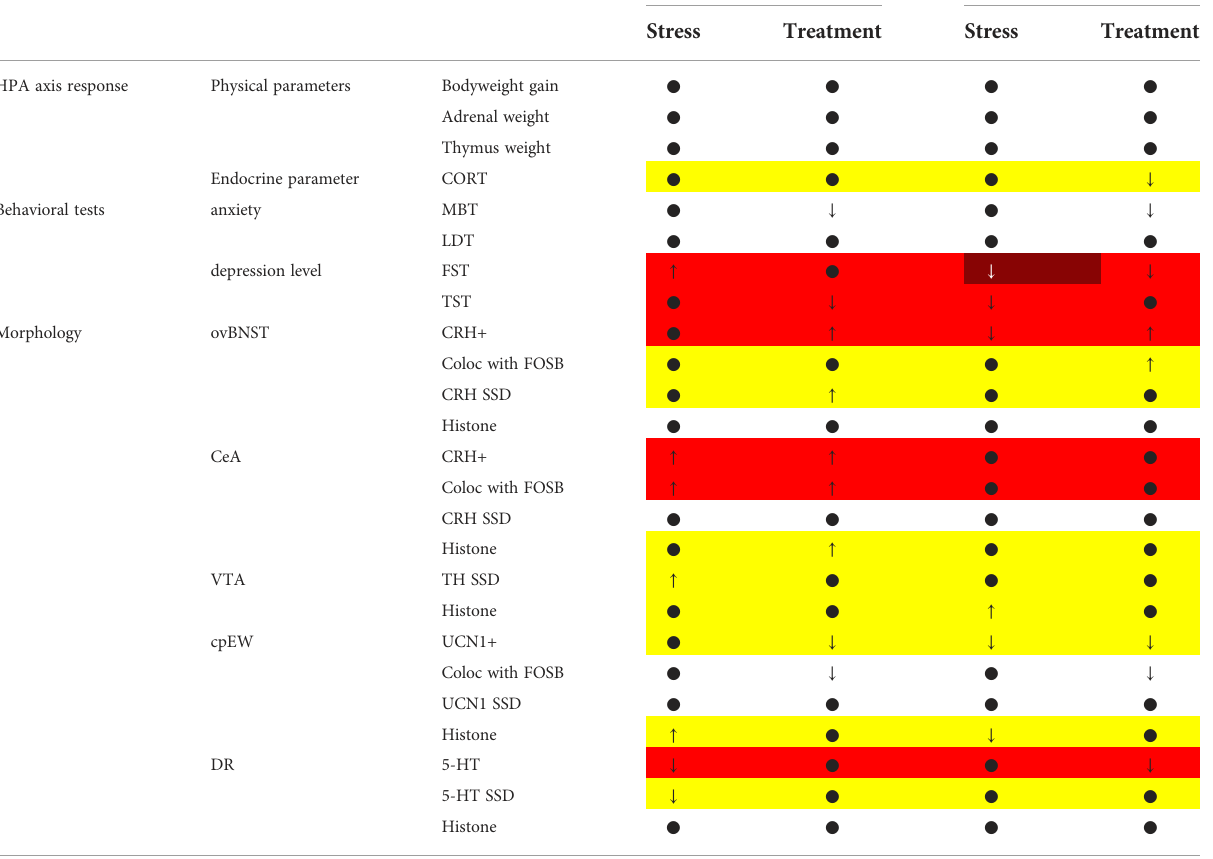
Yellow: effect of stress OR treatment was affected by maternal deprivation. Red cells: maternal deprivation affected BOTH stress AND treatment effects. Dark background refers to paradoxical/maladaptivechanges. ↑ increase, ↓ decrease, (cid:129) noeffectaccordingtotheposthoctests.Withinthemaincategory ‘ AFR ’ ,inthe ‘ Stress ’ column,theAFRcontrolvehiclegroupwas compared with the AFR stress vehicle group. In ‘ Treatment ’ column, the AFR control vehicle group was compared with AFR control fl uoxetine animals. In the main category ‘ MD180 ’ , in the ‘ Stress ’ column, the MD180 control vehicle group was compared with the MD180 stress vehicle group. In ‘ Treatment ’ column, the MD180 control vehicle group was compared with MD180control fl uoxetineanimals.AFR,animalfacility-reared;MD180,maternallydeprived; HPAaxis,hypothalamus-pituitary-adrenal axis;ovBNST, ovaldivisionofbednucleusofstria terminalis; CeA, central nucleus of amygdala; VTA, ventral tegmental area; cpEW, centrally projecting Edinger-Westphal nucleus; DR, dorsal raphe nucleus; CORT, corticosterone titer; MBT,marbleburyingtest;LBD,light-darkboxtest;FST,forcedswimtest;TST,tailsuspensiontest;CRH+,corticotropin-releasinghormoneimmunopositivecellcount;SSD,speci fi csignal density; Coloc with FOSB, histological co-localization of the given antigen and FOSB; TH, tyrosine-hydroxylase, UCN1+: count of urocortin1 immunoreactive cells, 5-HT+: count of serotonin immunoreactive cells, Histone: acetyl-lysine H3 histone